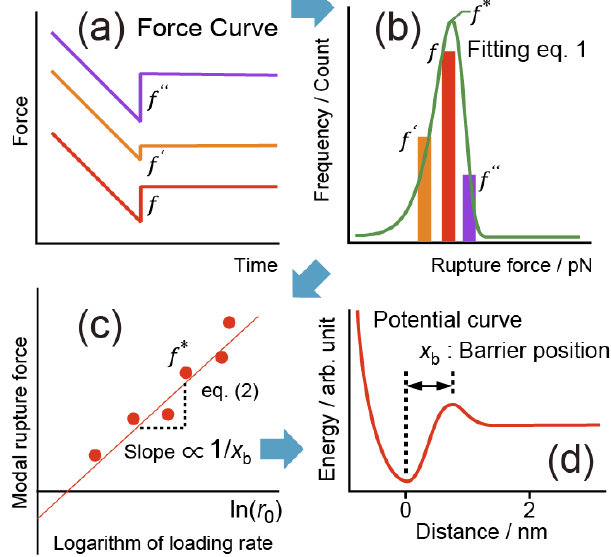
Figure 1. Schematic diagrams to explain the analysis method of Dynamic force spectroscopy (DFS). ( a ) Force curves; ( b ) Rupture force histogram. The modal rupture force is the most frequent rupture force [14] determined for each loading-rate measurement by fitting the rupture-force histogram with equation 1; ( c ) Modal rupture force as a function of loading rate; ( d ) Potential